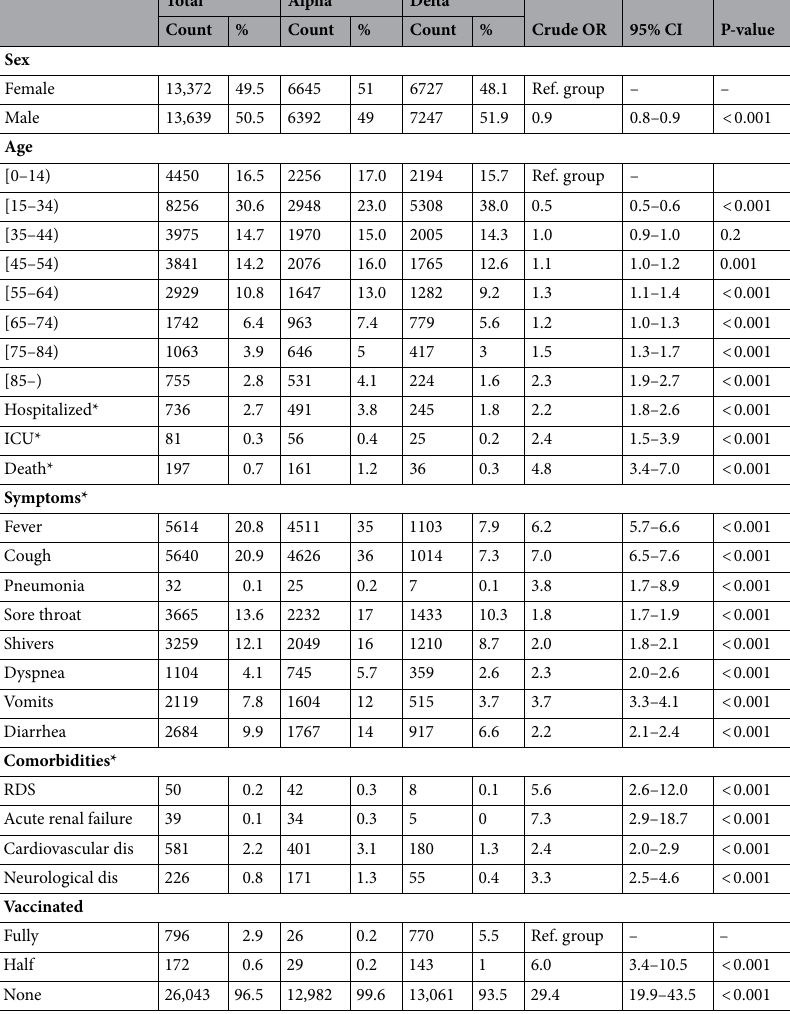
Table 1. Bivariate analysis of COVID-19 cases between the predominance of the Alpha and Delta variants in Lleida region (Spain). OR Odd Ratio, Ref. group Reference Group, CI Confidence Interval, ICU Intensive Care Unit, RDS Respiratory Distress Symptom, Cardiovascular dis cardiovascular diseases, Neurological dis neurological diseases. *For the variables Hospitalized, ICU, Death , and for Symptoms and Comorbidities the reference group was